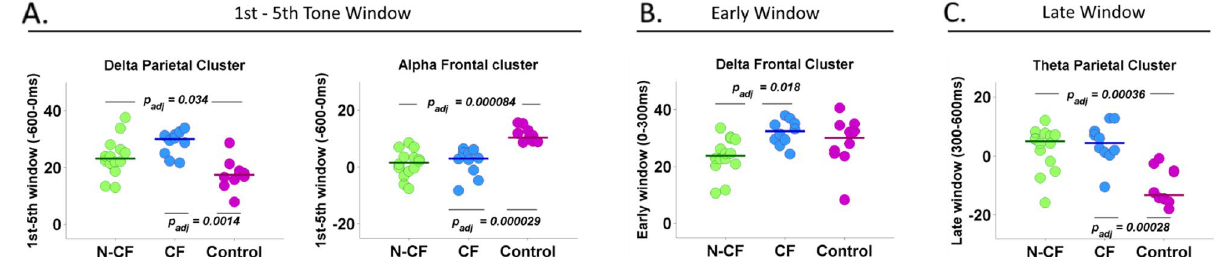
Figure 5. Mean contrast by group for the main spectral space/time variables selected for regularised multinomial regression. ( A ) ERS differences for the delta and alpha bands at parietal and frontal space cluster during the 1st–5th tone window. ( B ) ERS differences for the delta band at the frontal/early window. ( C ) ERS differences for the theta band at parietal/late window. Green dots display N-CF subjects, blue CF subjects, and purple control subjects. All p-value are corrected for multiple